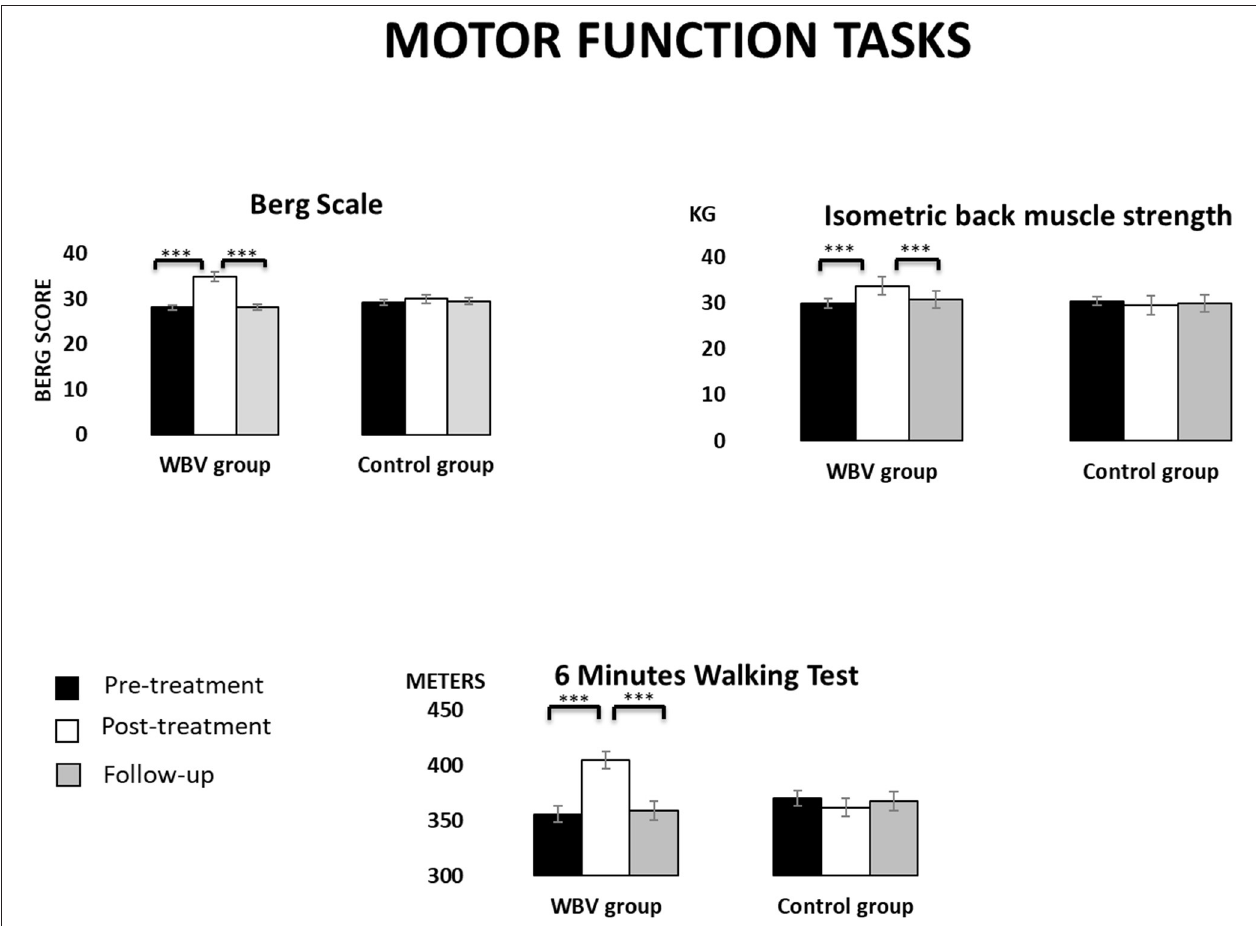
FIGURE 3 | Descriptive data (mean and TE) for the WBV group and the control group in motor function tasks at the three assessment times. *** p <